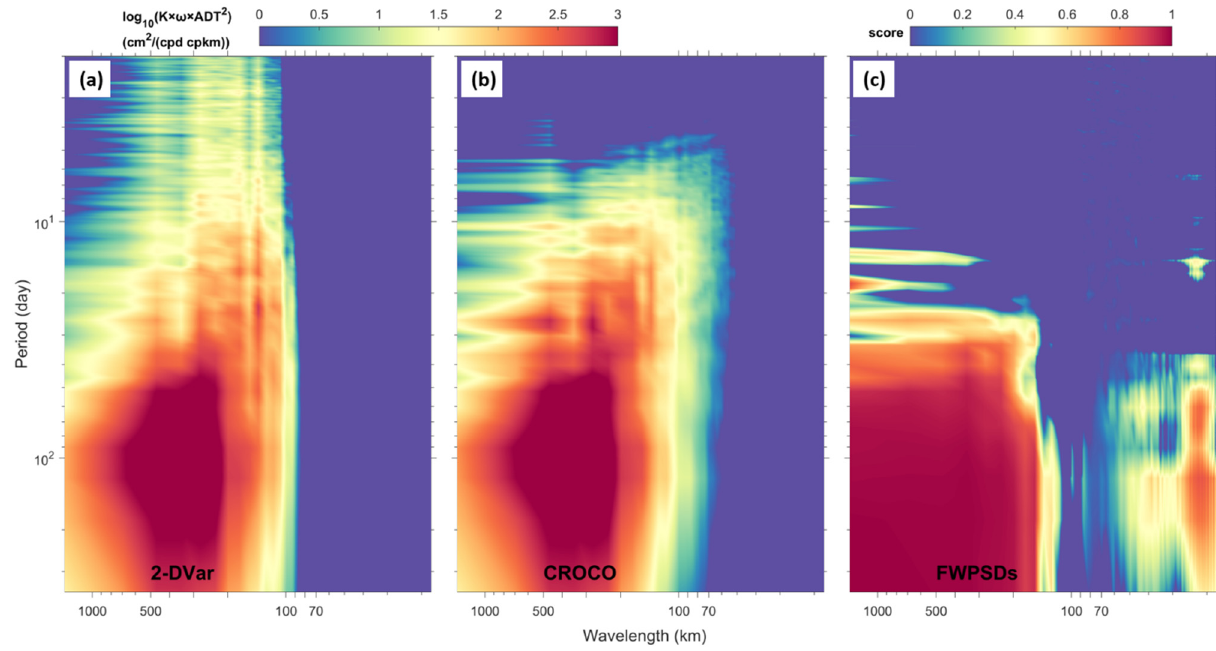
Figure 7. Horizontal wavenumber frequency spectral density of SSH in the ( a ) OSSE 2-DVar and ( b ) CROCO field. ( c ) FWPSD score of OSSE 2-DVar.